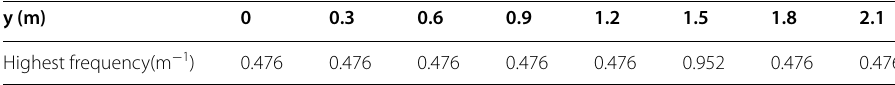
Table 3 Highest frequency of shape #1